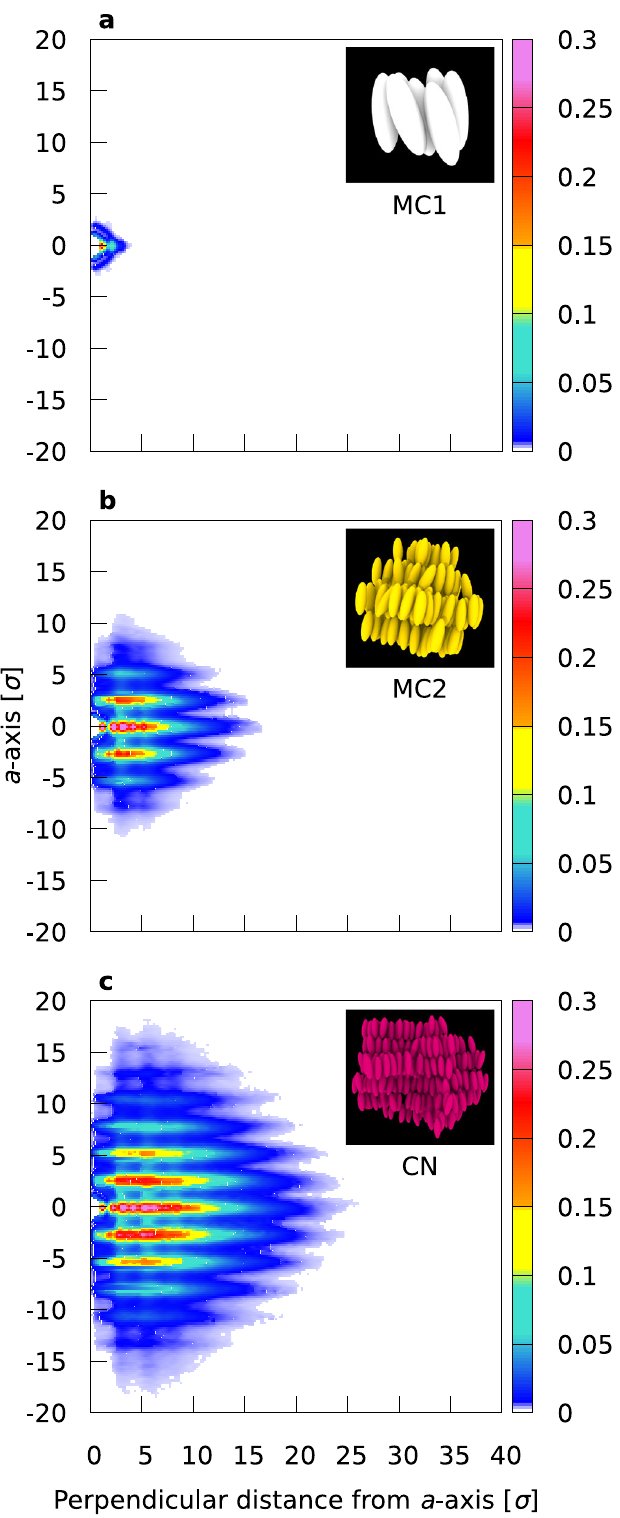
Fig. 3 Real-space pro fi les of metastable clusters and critical nuclei. Density pro fi les of a MC1, b MC2, and c CN. The density is circularly averaged about the a -axis that is parallel to the average orientation of the constituent molecules, and the horizontal axis is the distance to the a